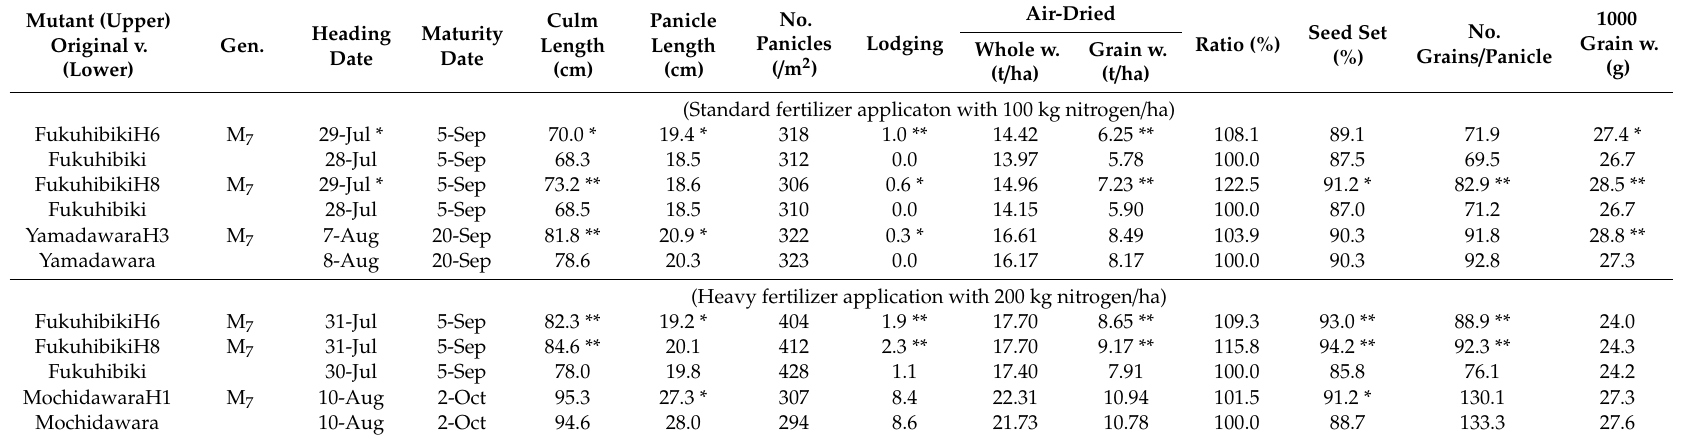
Table 4. Yield trial of mutants in paddy fields in Ibaraki, Japan in 2019.